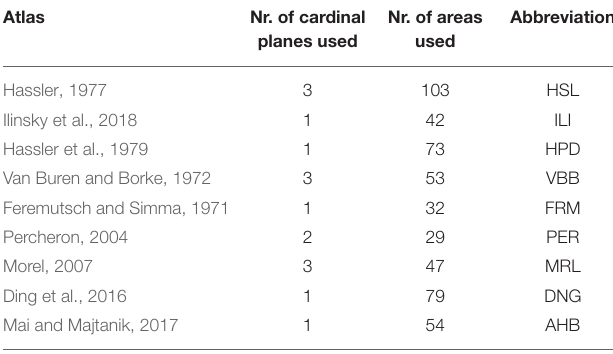
TABLE 1 | Thalamus atlases used in this